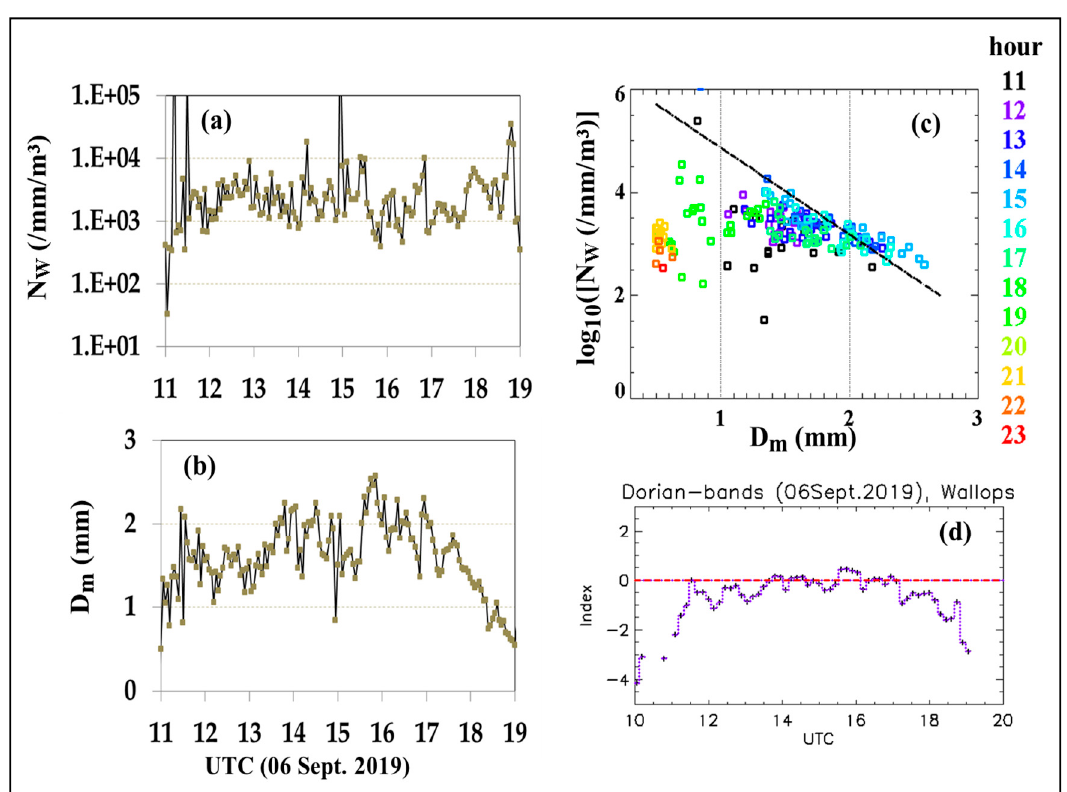
Figure 9. ( a ) N W and ( b ) D m variation with time from the 3 min composite DSDs, ( c ) log 10 (N w ) versus D m from the 3 min DSDs for each hour (color-coded), and ( d ) variation of the convective-stratiform rain index with time.